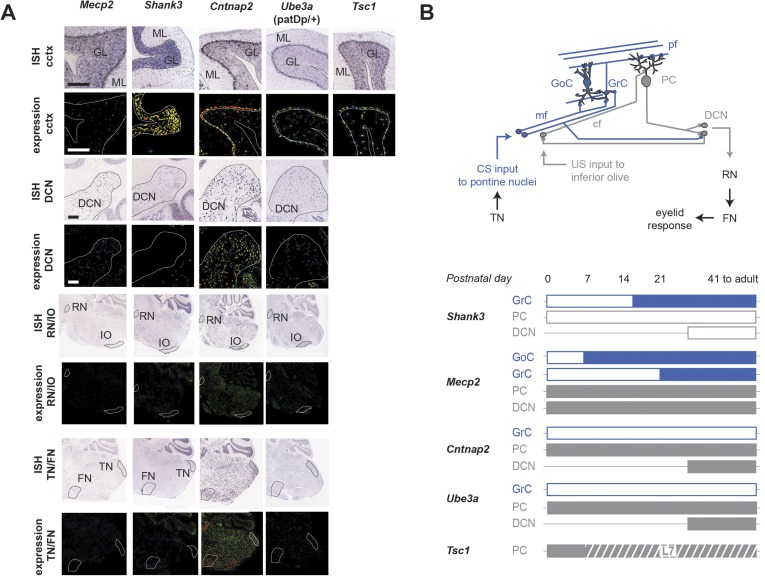
Expression patterns of ASD model genes in cerebellum.(A) In situ hybridizations and expression quantification from Allen Brain Atlas (ABA; Lein et al., 2007) indicate expression patterns of autism spectrum disorder (ASD)-related genes in the cerebellar cortex (cctx), the deep cerebellar nuclei (DCN), the red nucleus and inferior olive (RN/IO), and the facial nucleus and the trigeminal nucleus (FN/TN). Displayed here are Shank3, Mecp2, Cntnap2, and Tsc1. Note that one gene in the imprinted region 15q11-13 with disease linkage (Albrecht et al., 1997; Piochon et al., 2014), Ube3a, with is also shown. Scale bars, 200 μm. P41 to adult data include P56 data from the Allen Brain Atlas. (B) Top: the canonical cerebellar circuit. Input along the CS (blue) pathway via mfs from the pontine nuclei enters the cerebellar cortex through granule cells (GrC), which receive feedforward and feedback inhibition from Golgi cells (GoC) in the granule cell layer. GrCs send pf projections to PC dendritic arbors. PCs also receive teaching signals along the US (gray) pathway via cfs from the inferior olive. The output of clustered PCs (gray) converges onto neurons in the cerebellar nuclei (DCN), which drive downstream neurons in the output pathway. Bottom: gene expression from birth to adulthood, by cell type. Full bars indicate strong expression as found in the literature. White bars indicate little or no expression, and a horizontal thin line indicates no data available. The hashed bar indicates the period during which Tsc1 is expressed in wild-type animals but knocked out in the L7-Tsc1 animals. References: Shank3 (Böckers et al., 2004; Böckers et al., 2005), Mecp2 (Shahbazian et al., 2002b; Mullaney et al., 2004; Neul and Zoghbi, 2004; Dragich et al., 2007; Schmid et al., 2008), Tsc1 (Tsai et al., 2012), Ube3a (a gene strongly implicated in neurodevelopmental disorders in locus 15q11-1: Albrecht et al., 1997; Dindot et al., 2008), Cntnap2 (Fujita et al., 2012; Paul et al., 2012).